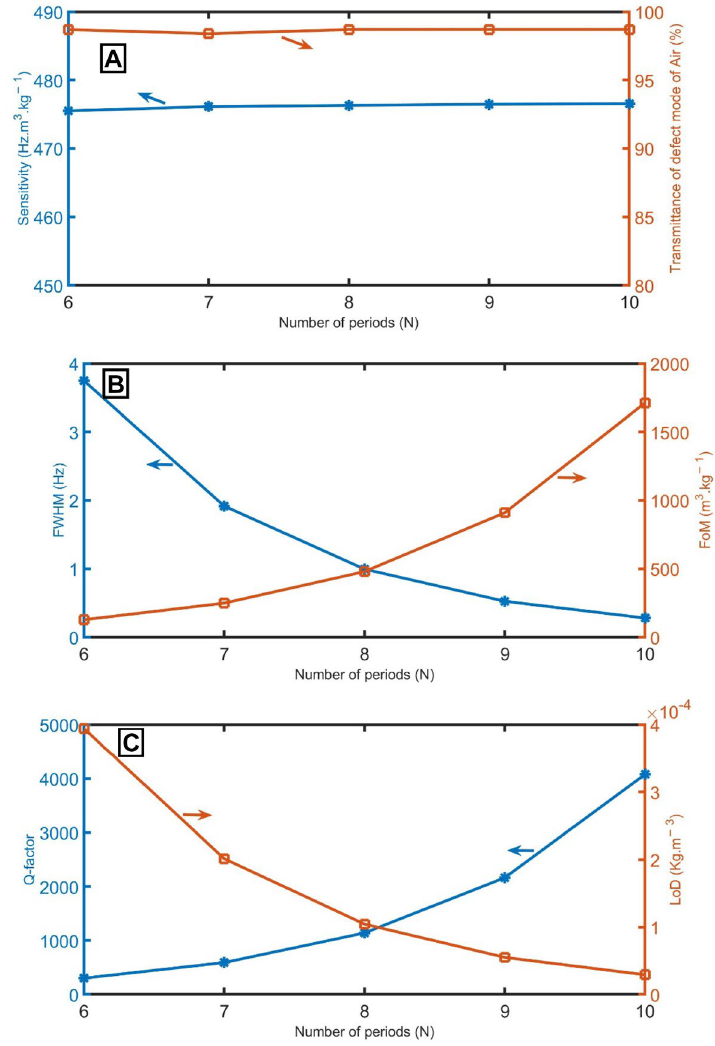
Figure 9. ( A ) sensitivity between air and pure CH 4 samples and transmittance of the resonant mode of air samples, ( B ) FWHM of the resonant mode of air samples and FoM , and ( C ) Q-factor and LoD of the proposed gas sensor at different numbers of unit